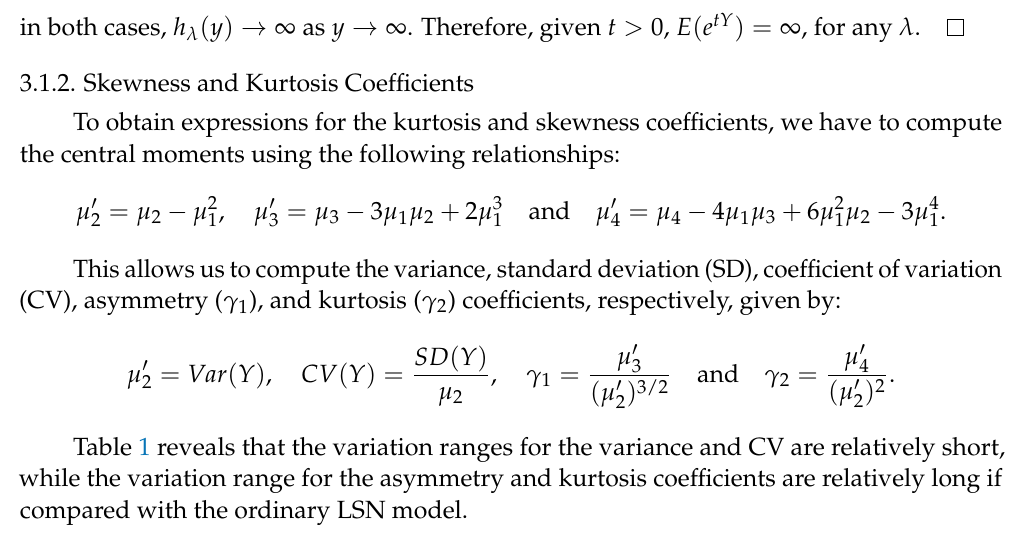
Table 1. Range of values for statistics corresponding to variance, CV, skewness, and kurtosis. Statistics Variance